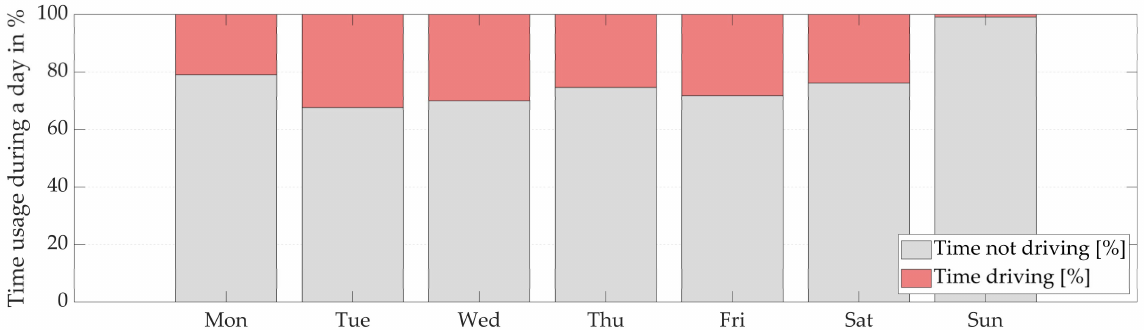
Figure 10. Diagram representing the share in% of the operation time and vehicle pause for the fleet analyzed during the